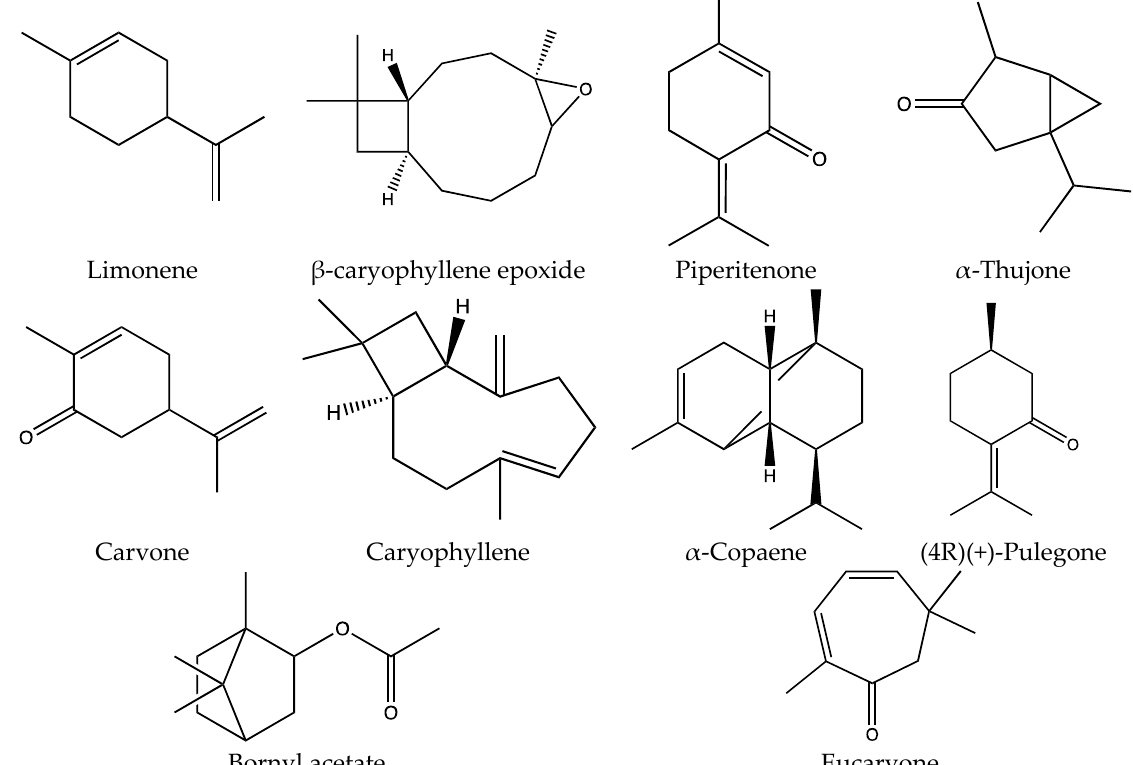
Figure 2. The main compounds identified in essential oils and polyphenols from Lippia turbinata extracted for conven- tional methods.